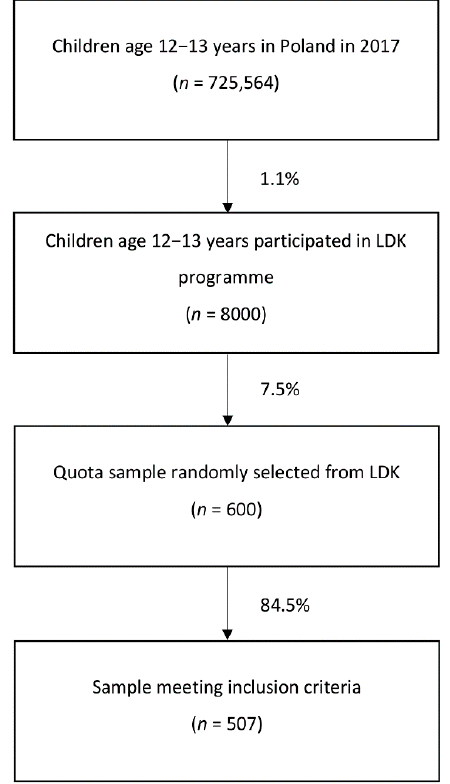
Figure 1. The selection of participants for the Athletics for All program, based on Statistical Demography Yearbook for 2017 [26].